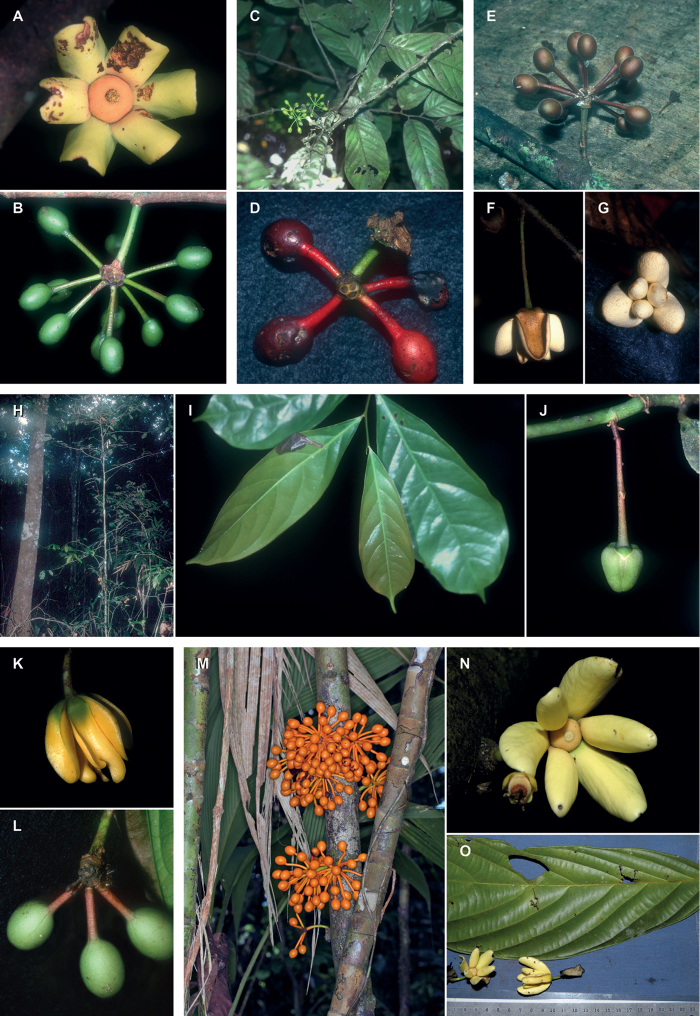
a, bCremastospermaleiophyllum R.E.Fr. a flower b fruit (Pirie et al. 2; photo LWC) c, dCremastospermamegalophyllum R.E.Fr. c habit (Maas et al. 8577, photo: PJMM), fruit (Maas et al. 8595, photo PJMM) e–gC.microcarpum R.E.Fr. e fruit (Maas et al. 6281; photo PJMM) f, g flower (Maas et al 8222; photo PJMM) h–jC.monospermum (Rusby) R.E.Fr. h habit i leaves j flower bud (Pirie et al. 5; photos LWC) k, lC.oblongum R.E.Fr. k flower l fruit (Maas et al. 9148; photos PJMM) m–oC.osicola. m fruit n flower o leaf and flower with scale bar (photos Reinaldo Aguilar).